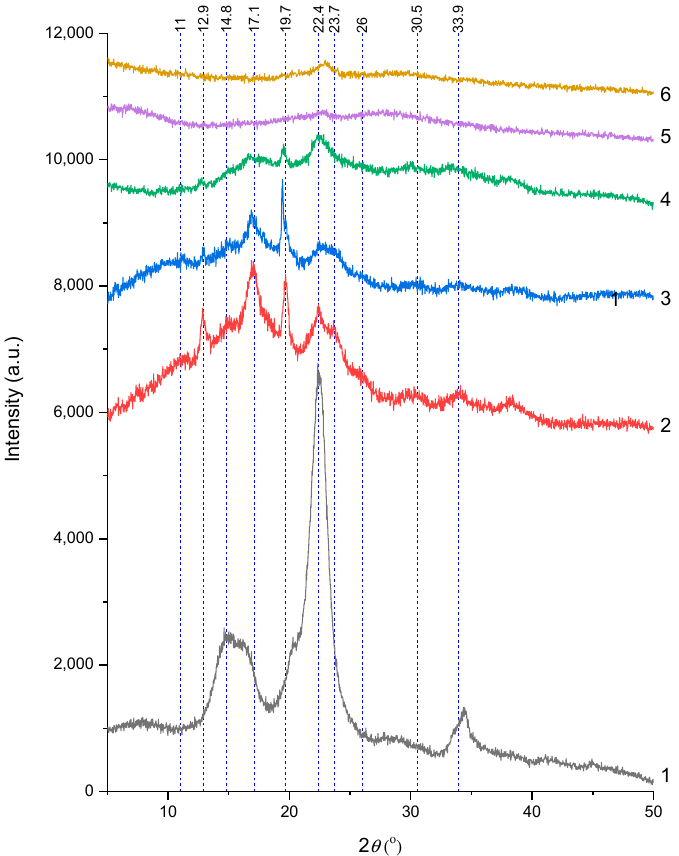
Figure 5. XRD results of (1) native microcrystalline cellulose (MCC), (2) native Gelose 80 starch, (3) C00 film, (4) C07 film, (5) C70 film, and (6) C100 film.